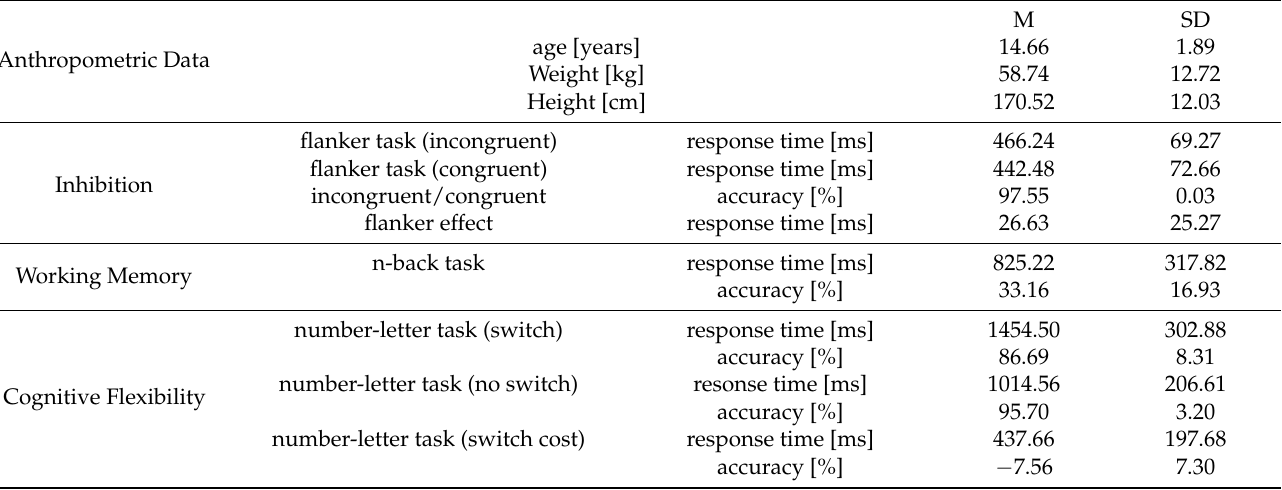
Table 1. Anthropometric data, characteristics, and EF-measure data of the soccer players (mean values and standard